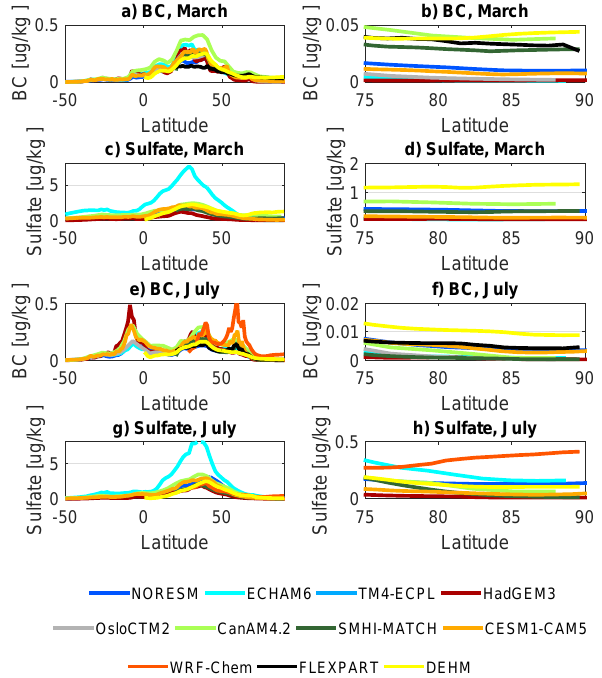
Figure 2. BC (a, c) and sulfate (b, d) column mass loadings for the year 2008 averaged over all longitudes as a function of latitude (for the range 50 ◦ S to 90 ◦ N) for March (a – b) and July (c – d) .